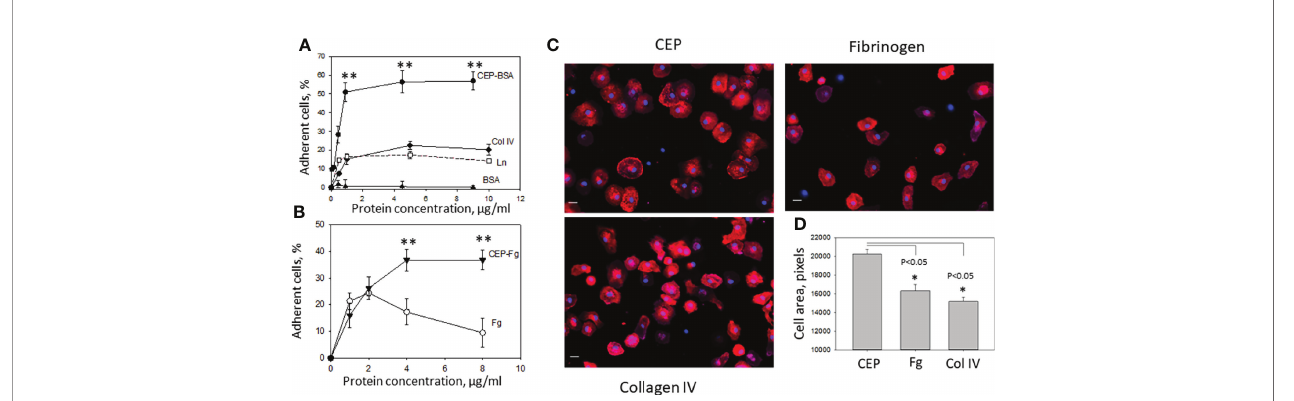
FIGURE 3 | Adhesion of M1-polarized macrophages to CEP and ECM proteins. (A) Different concentrations of CEP-BSA, collagen IV (Col IV), laminin (Ln) and BSA were immobilized on a 96-well plate for 3 h at 37°C. Fluorescently labeled macrophages were added to the wells and cell adhesion was determined after 30 min in a fl uorescence plate reader. CEP-BSA is presented based on the concentration of BSA. 1µg BSA contains 250 nM CEP. A representative experiment from 4 performed. Data are presented as mean ± SEM **p < 0.01. (B) Different concentrations of CEP- fi brinogen (CEP-Fg) and fi brinogen (Fg) were immobilized and tested in an adhesion assay as described above. A summary result from 3 experiments. CEP-Fg is shown based on the concentration of Fg. 1µg Fg contains 87 nM CEP Data are presented as mean ± SEM **p < 0.01. (C) Macrophages were allowed to adhere to glass coverslips coated with fi brinogen, Collagen IV or CEP-BSA for 1 hour at 37°C. Macrophages were fi xed with 2% paraformaldehyde, permeabilized with 0.1% Triton X-100, and incubated with Alexa Fluor 555-conjugated phalloidin and DAPI. Fluorescent images were obtained with EVOS FL auto cell fl uorescent imaging system using 20x objective with mosaic 9- fi elds setup. (D) The cell area was calculated using Imaris 8.0 software. Data are presented as mean ± SEM *p <